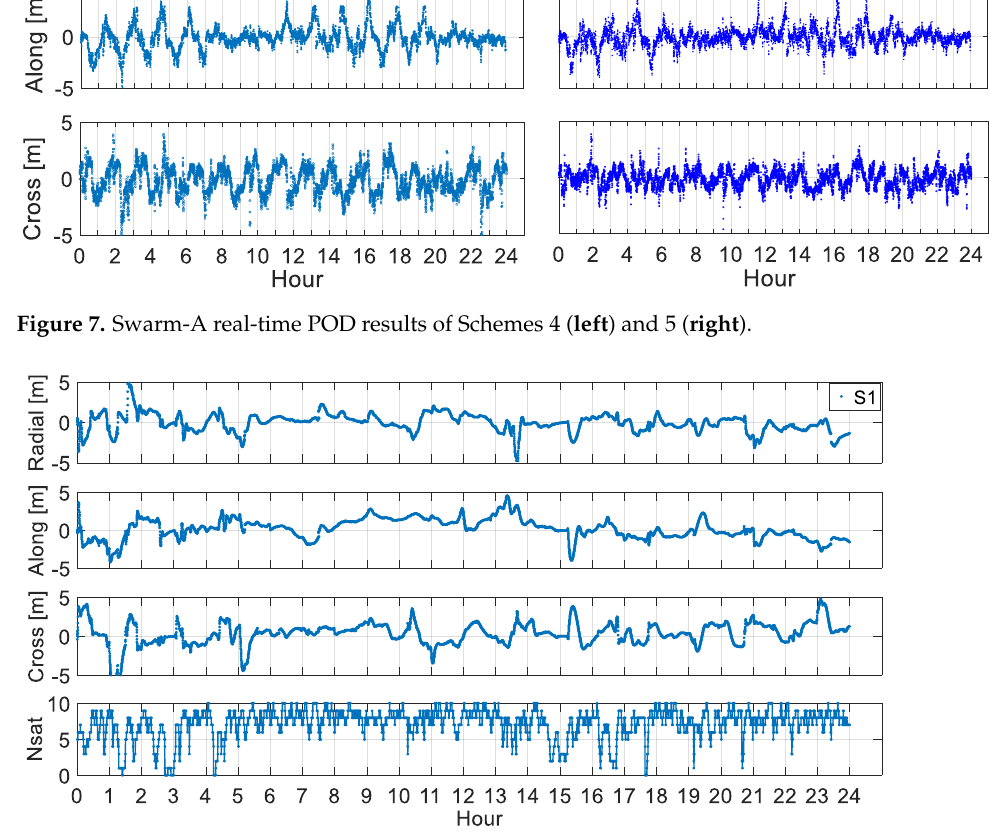
Figure 8. GRACE-A real-time POD results of Scheme 1.